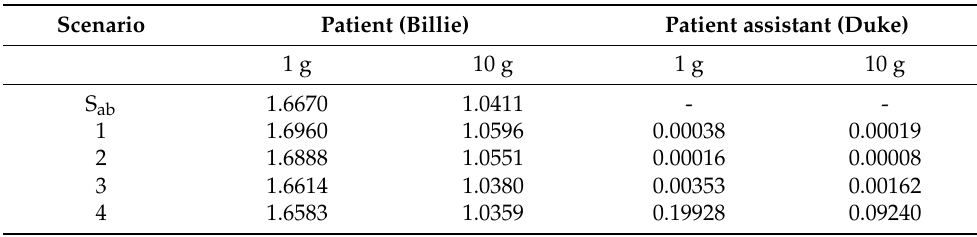
Table 2. Peak spatially averaged SAR (W/kg) in Billie (patient) and Duke (patient assistant) according to head RF coil (input power = 1 W).